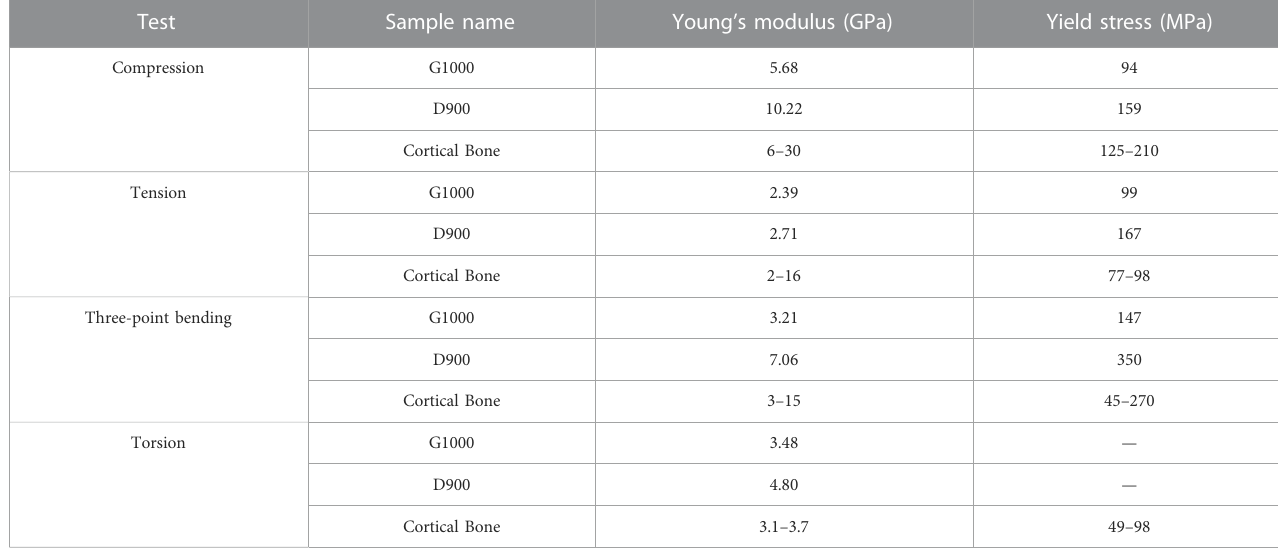
TABLE 2 Comparison of experimentally derived mechanical properties of two different scaffolds (Naghavi et al., 2022c). Dash (-) indicates absence of data.